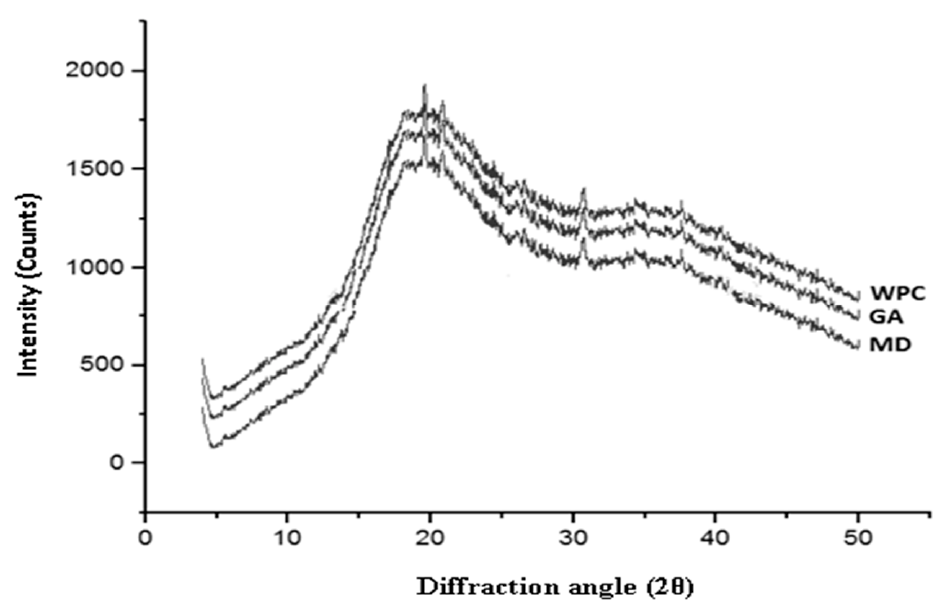
Figure 2. XRD pattern of nutritionally rich honey powders fortified with different carrier agents.